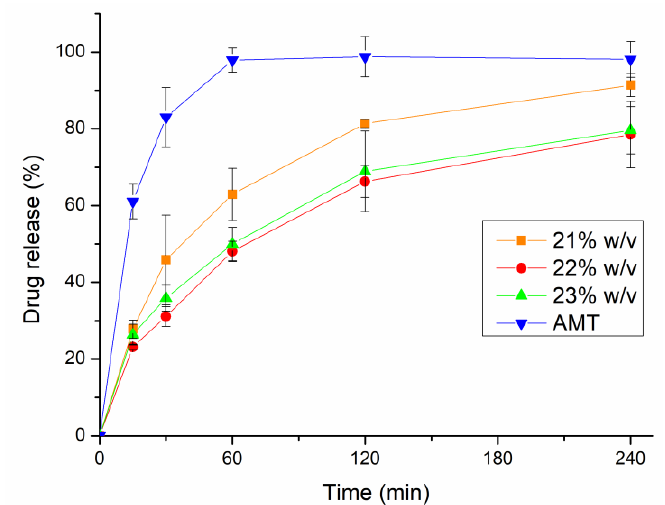
Figure 6. In vitro drug release profile of AMT-loaded in situ gelling thermosensitive nasal formulations (21, 22, and 23% w / v ) in comparison to initial AMT. Data are presented as means ± SD, n = 3.